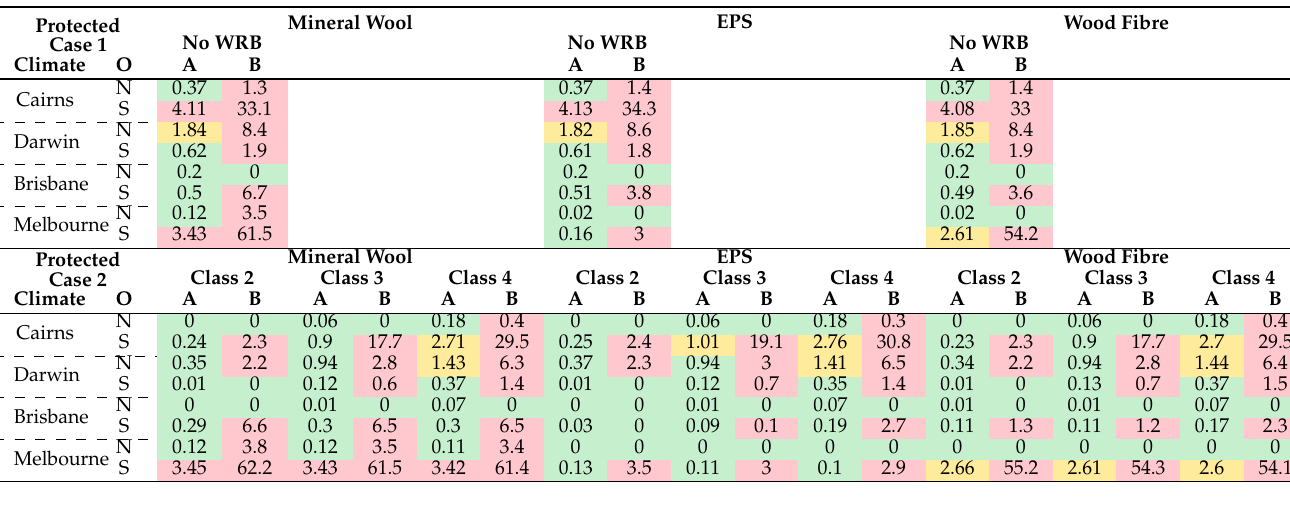
Table 13. Unprotected CLT results for internal insulation. O (orientation). Performance criteria: A (mould growth index), B (corrosion rate). Classification of WRB: Class 2, 3, and 4 (vapour permeance). Green (pass), red (fail), or yellow (further